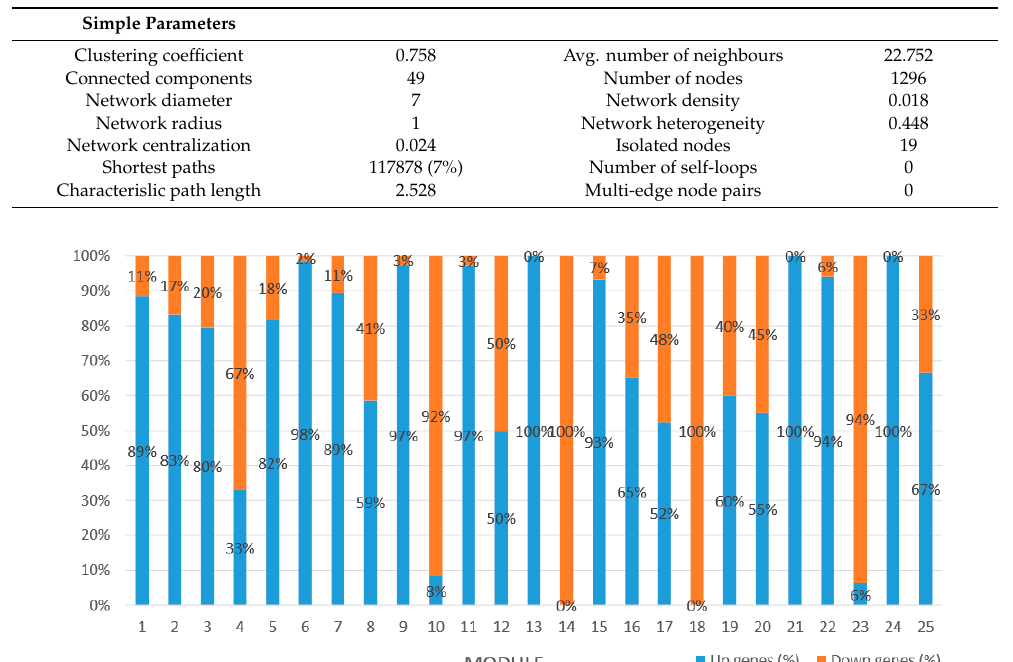
Table 5. Parameters of GCN and HRR between co-expression genes.